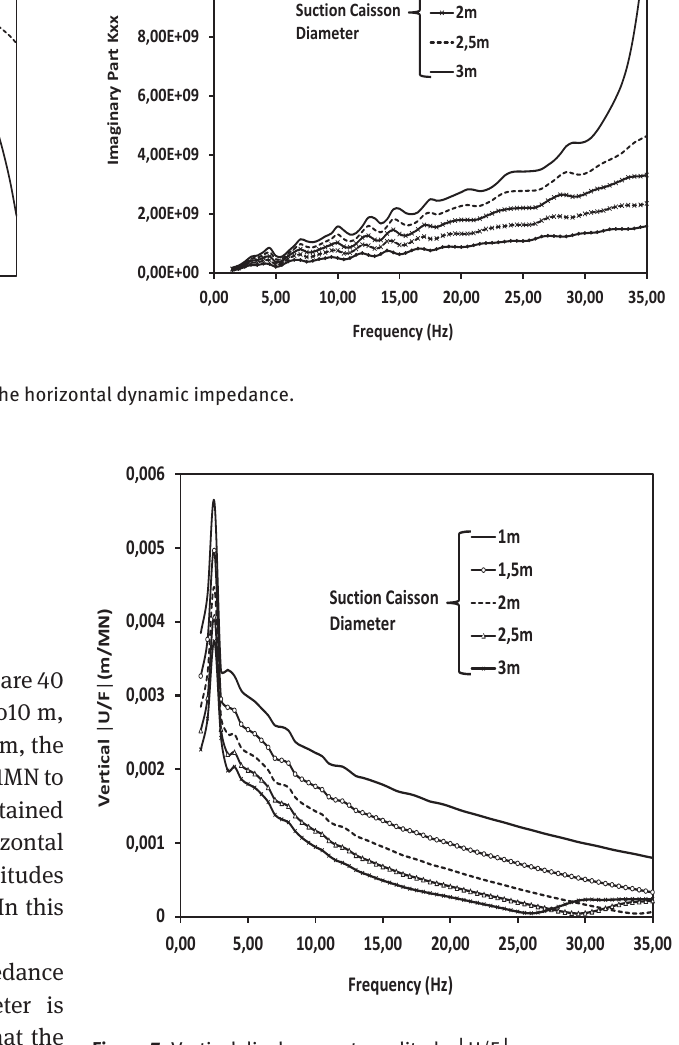
Figure 8 Horizontal displacement amplitude │U/F│̶